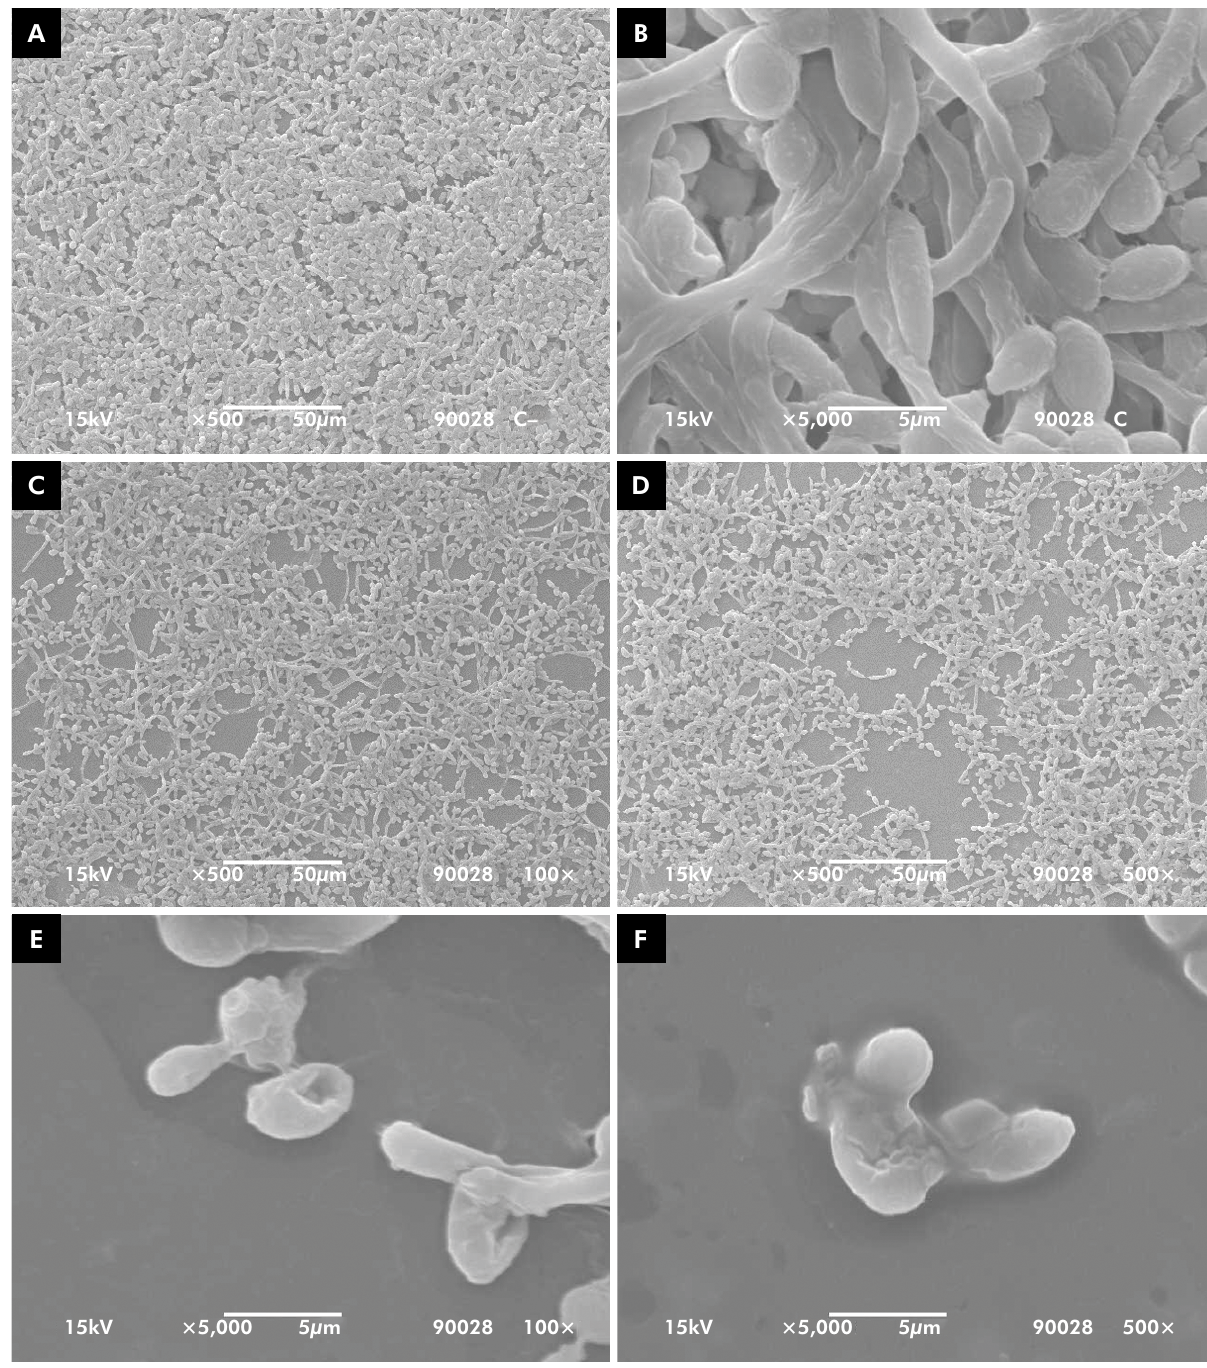
Figure 2. SEM of C. albicans ATCC 90028 showing the cellular morphology. In the first column: untreated biofilm (a), treated with A. colubrina 100x MIC = 1950 ug/mL (c) and biofilm treated with A. colubrina 500x MIC = 9750 ug/mL (e), in a 500x view. In the second column, the same findings may be observed at a 5,000x view